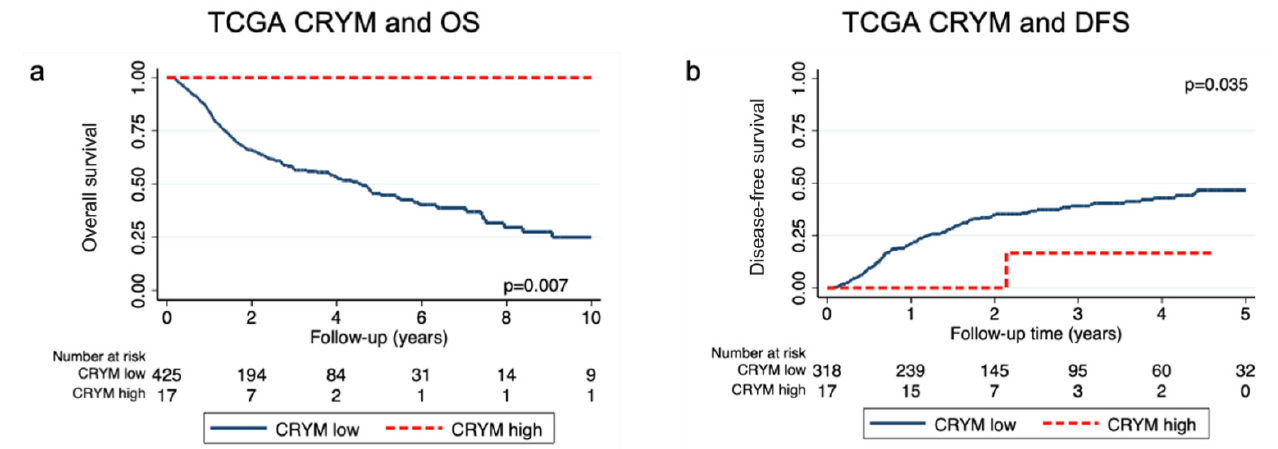
Figure 3. Kaplan–Meier estimator for OS ( a ) and KM failure function for DFS ( b ) of the secondary dataset.